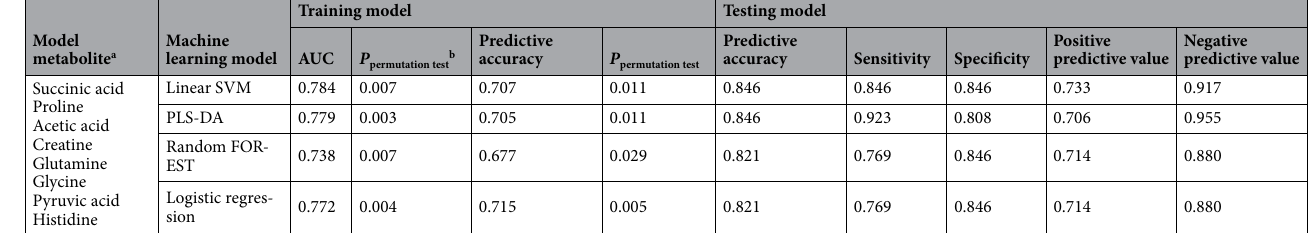
Table 4. Model of metabolites in MDD with full remission using different types of machine learning algorithm. MDD major depressive disorder, AUC area under the receiver operating characteristic curve, SVM support vector machine, PLS-DA partial least squares-discriminant analysis. a Metabolites for which p < 0.05 were selected. b 1000 random permutations were performed for validation testing.